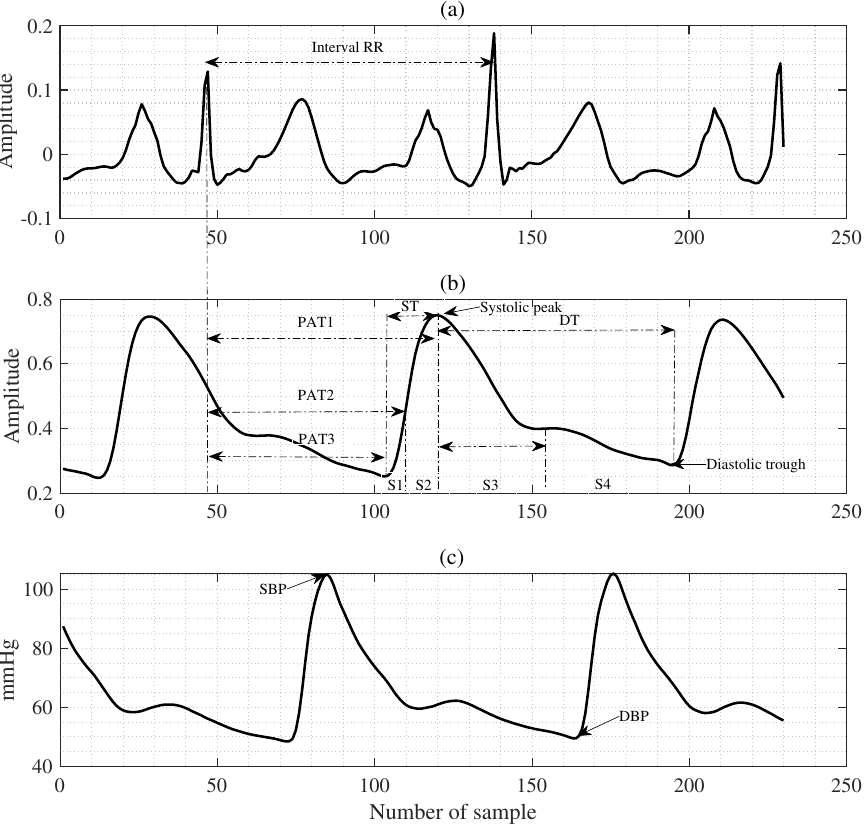
Figure 2. Feature extraction from the PPG with ECG signal, where ( a ) is an ECG signal example, ( b ) denotes a PPG signal example, and ( c ) is a target signal (ABP) example. The pulse arrival time (PAT) denotes the time interval between the R peak of the ECG signal and PPG rise points, and both PAT and PTT are essential features for estimating BP values [14,24,25]. Another essential feature is the PPG’s pulse intensity ratio, represented to be inversely proportional to the diastolic trough [14]. The waveform associated with the heart rate cycle can be observed through the PPG signal. Thus, the PPG signal waves were defined as pulses, each corresponding to a cardiac cycle, with the rising edge as the systolic time (ST) and falling edge as the diastolic time (DT) [14]. In addition, the area in the pulse corresponding to the ST was used as the systolic area (Sa), and the area in the pulse corresponding to the DT was used as the diastolic area (Da) [24]. As shown in Figure 2, each pulse waveform was divided into these two areas. Therefore, the features of each pulse were extracted, including Sa, Da, ST, DT, and cycle duration, to extract features that effectively estimate BPs and CIs. Figure 3 shows the 1st and 2nd derivatives of the PPGs. These